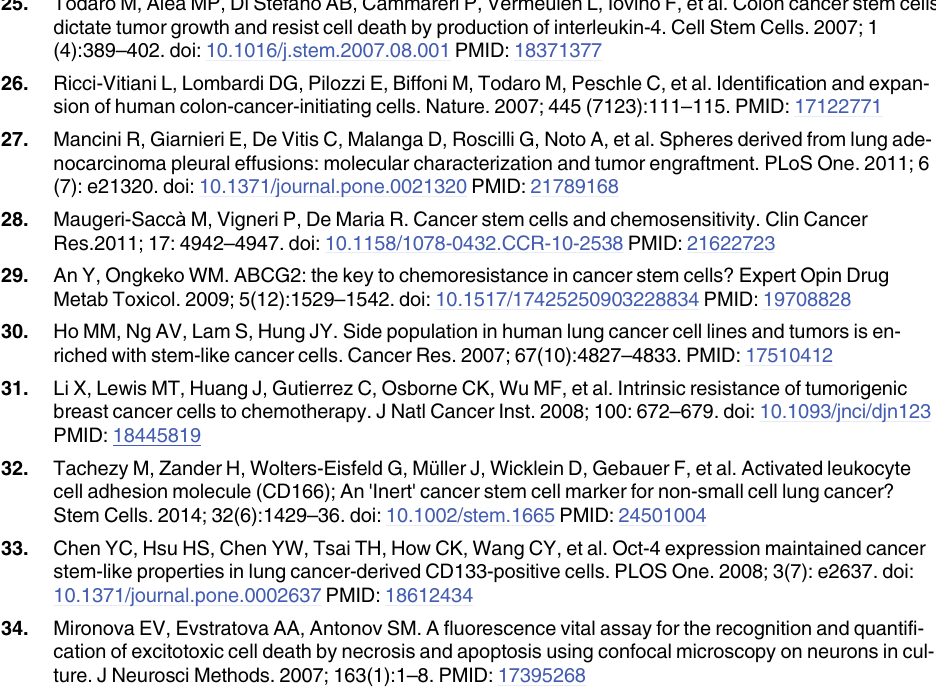
PLOS ONE | DOI:10.1371/journal.pone.0125037 May 8,